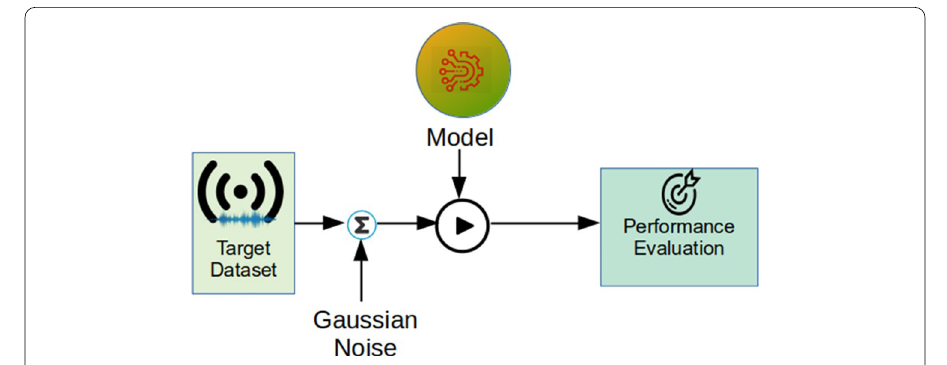
Fig. 15 Noise experiment process